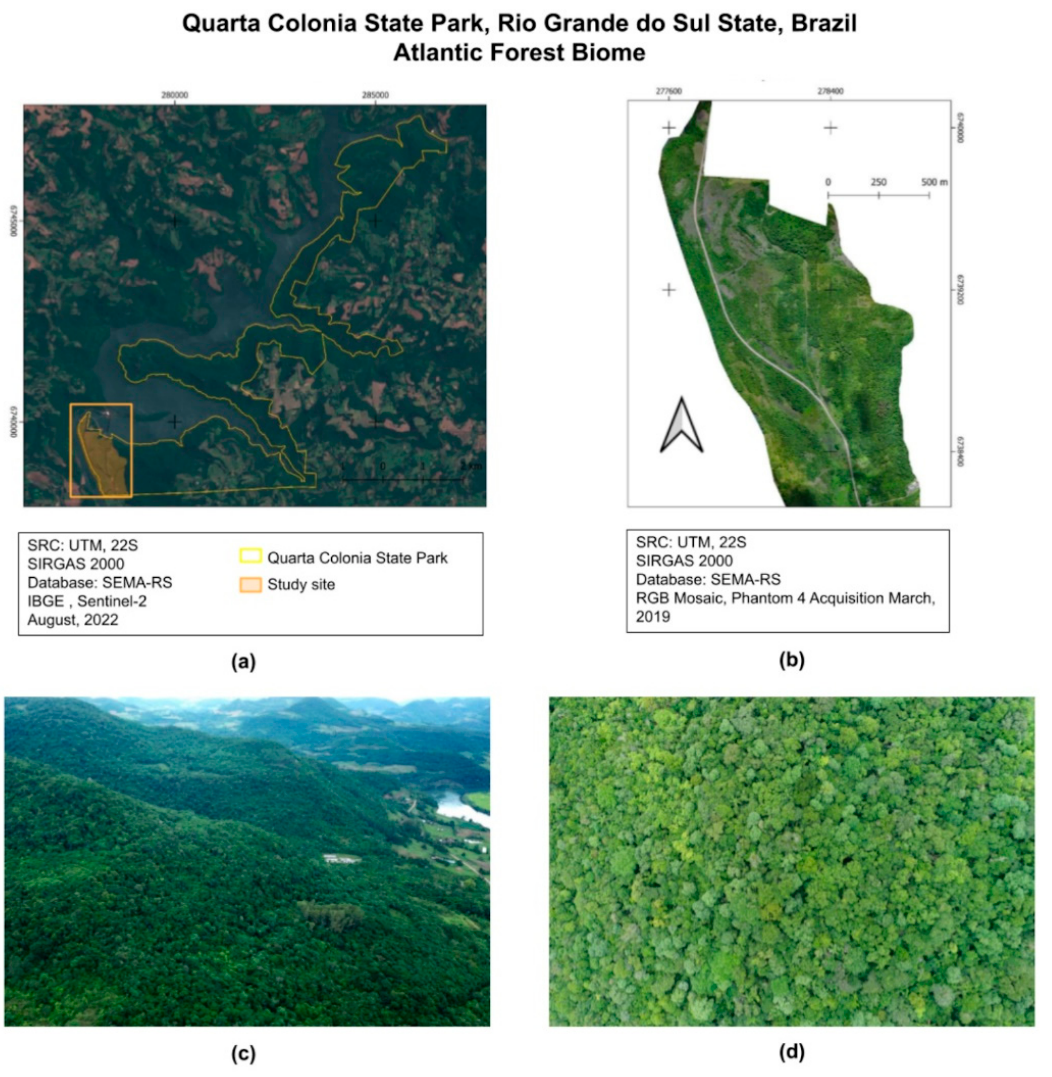
Figure 1. Images show: ( a ) Quarta Colonia State Park (QCSP); ( b ) closer view of the study site; ( c ) aerial view image of woody cover and QCSP head office; and ( d ) secondary forest canopy.